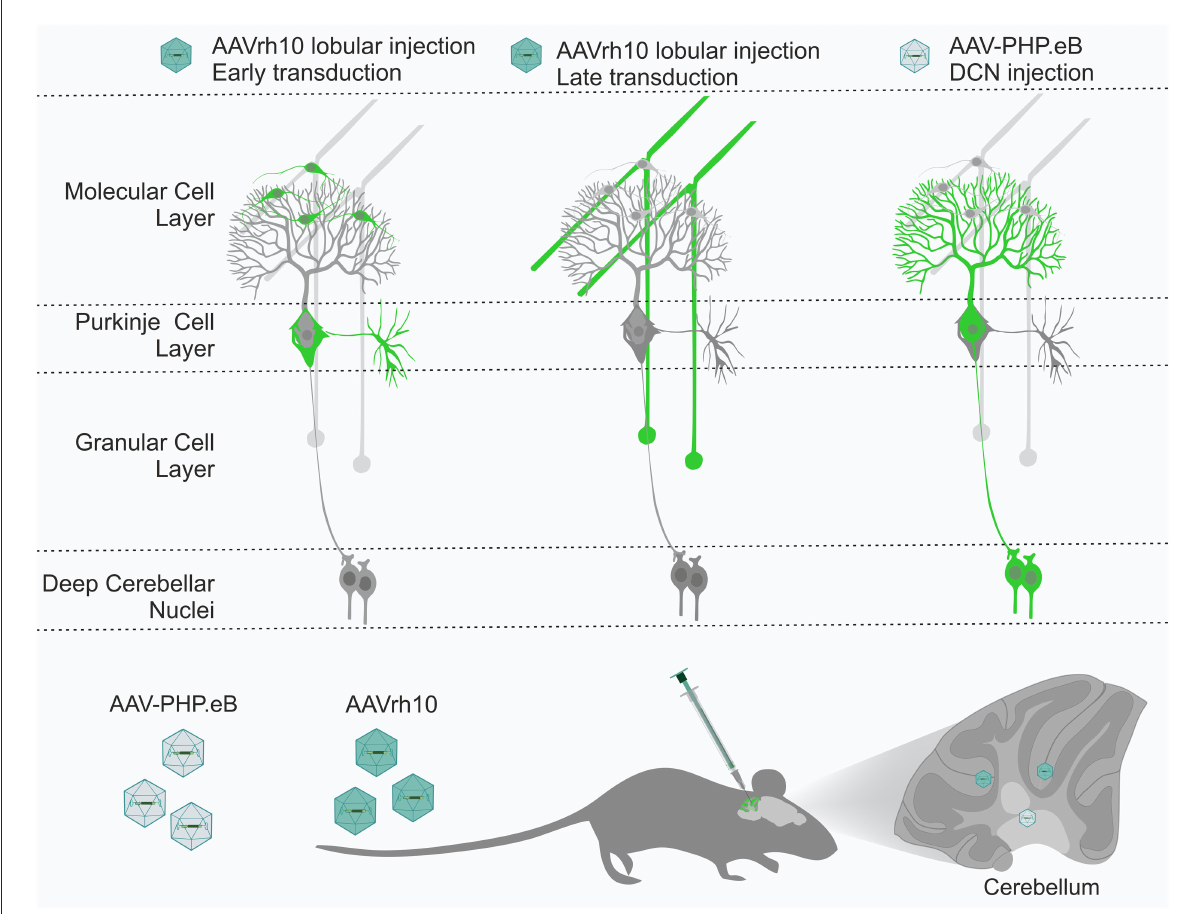
FIGURE9 The cerebellum has several layers and structures, with many cell types, including Purkinje cells, granule neurons, stellate neurons, and basket neurons. All cell types are tightly interconnected by their axonal and dendritic processes, forming a perfect framework for retrograde delivery of AAV-based therapies to cell types of interest. We demonstrated that the AAVrh10 and AAV-PHP.eB viral particles placed in the vicinity of the axonal terminals by targeted brain injections into lobules, and deep cerebellar nuclei (DCN) can selectively transduce neuronal types of cerebellar networks, such as Purkinje cells and granule cells. AAVrh10 injected into lobules produces early transduction in stellate and basket cells. Subsequently, AAVrh10 retrogradely transduces granule cells. AAV-PHP.eB injected into DCN at the axonal terminals of Purkinje cells produces their selective transduction. Therefore, both serotypes can be used in a retrograde mode for selective transduction of major neuronal types in the cerebellum for effective and selective gene delivery. DCN, deep cerebellar